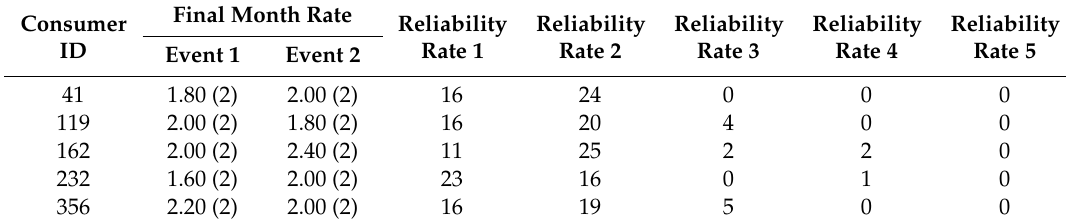
Table 10. Final Reliability Rate from selected consumers when using Method 2.